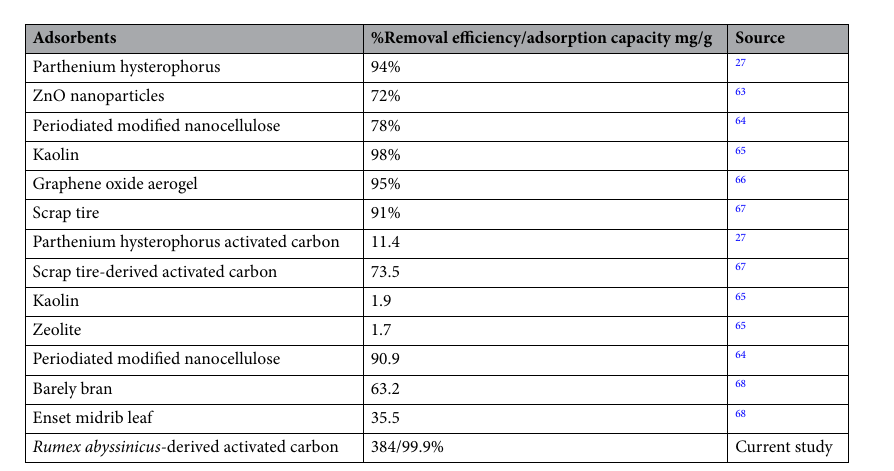
Table 4. Comparison of MB removal efficiencies of different